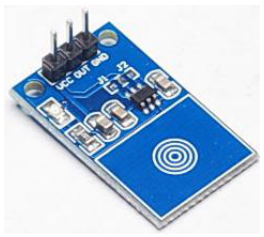
Figure 7. TTP223 human touch module.